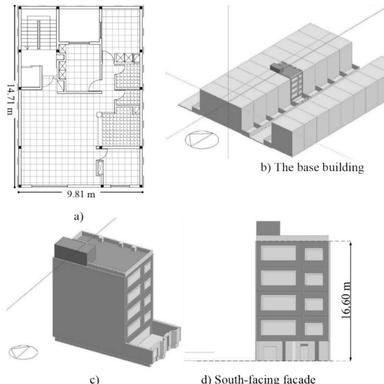
The schematic of the case study; a) the second-floor plan; b) the case study at neighborhood scale; b) the 3D model of the selected building in DesignBuilder software; and c) the south facade.